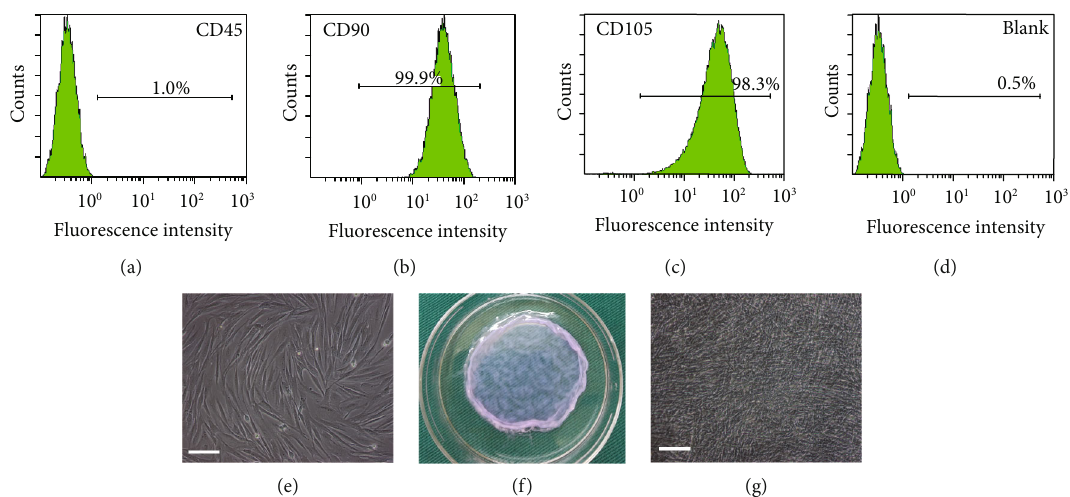
Figure 1: Canine ADSC culture and ADSC sheet formation. (a – d) ADSCs were negative for hematopoietic marker CD45 and were strongly positive for MSC-related markers CD90 and CD105. The unlabeled cells were used as the blank control. (e) The primary cultured ADSCs were isolated from fat tissue of beagle dogs (scale bars: 100 μ m). (f) ADSC sheets were obtained after 21 days of continuous cell culture. (g) ADSC sheets observed by inverted phase contrast microscopy ( × 100) and cell tight junction and surrounded by abundant ECM (scale bars: 100 μ